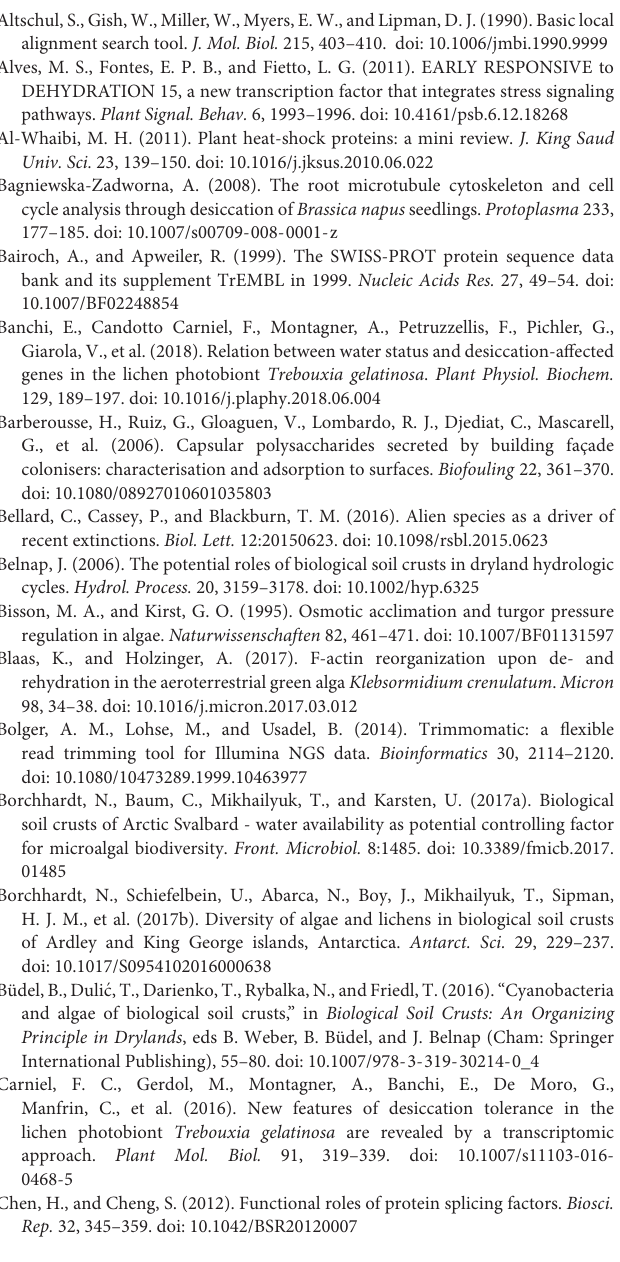
TABLE S1 | Statistics of the sequencing outcome. The number of read pairs, quality pairs, quality merged reads, quality single reads, and the mapping